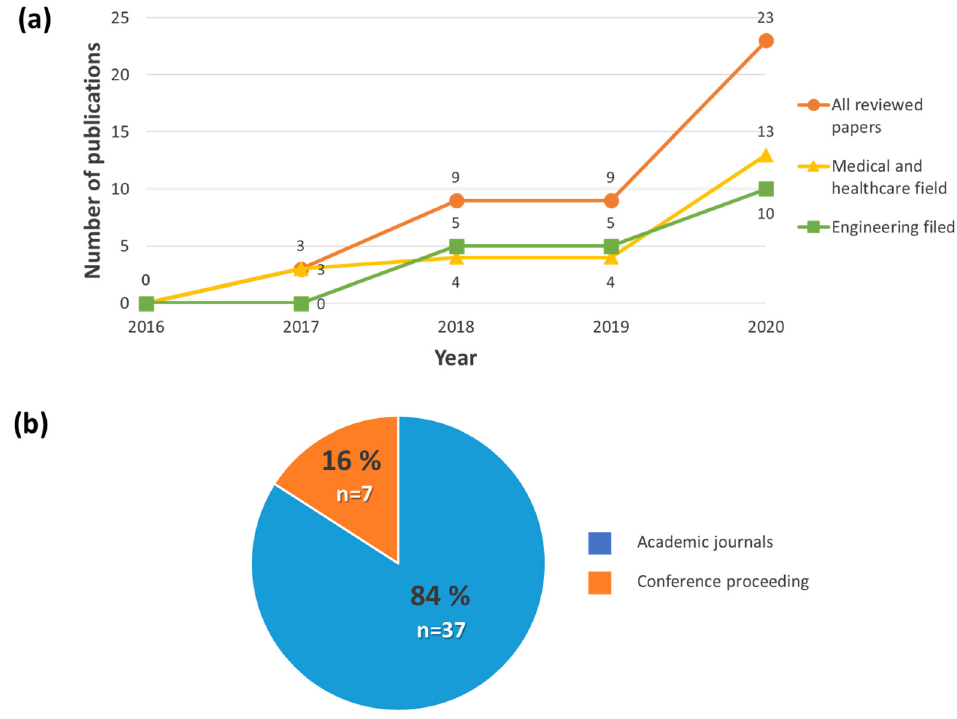
Figure 13. Number of publications related to HoloLens research by ( a ) year and ( b ) source of